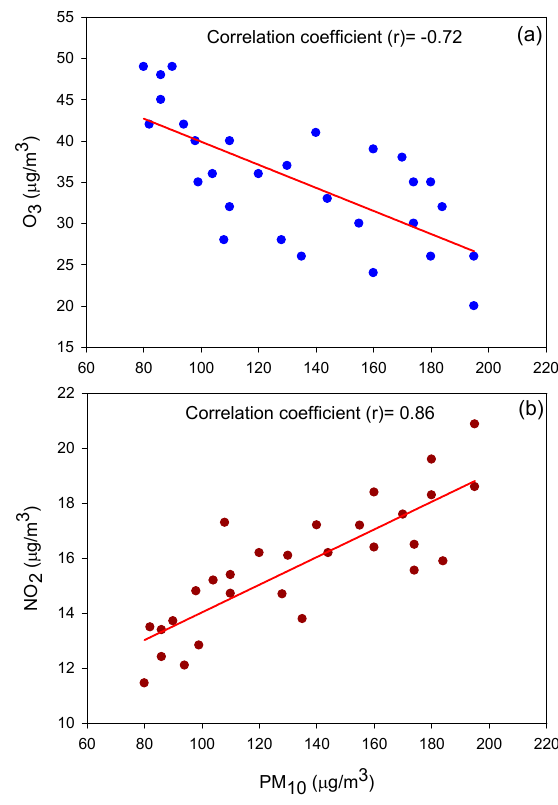
Figure 10. Correlation between ( a ) PM 10 and O 3 and ( b ) PM 10 and NO 2 .